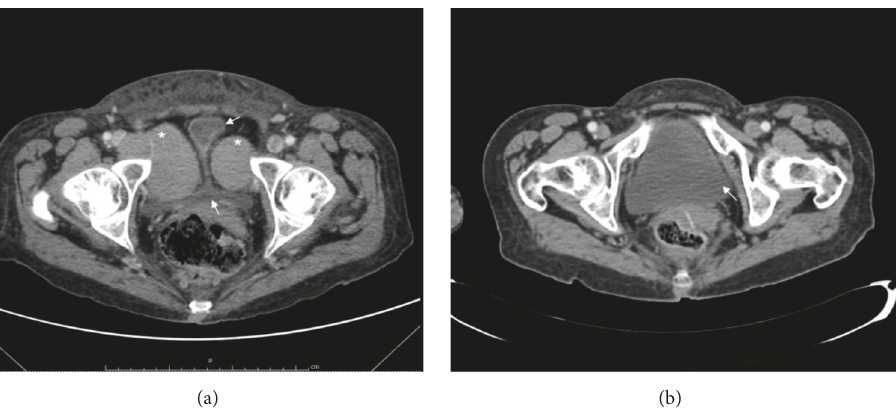
Figure 1: Pelvic CT before treatment with rituximab plus idelalisib (a). Hourglass deformity of urinary bladder (arrows) was seen as a result of the compression of two extraperitoneal paravesical soft tissue bulky masses (asterisks). After three months of idelalisib (b) a complete resolution of the masses was observer with a normal